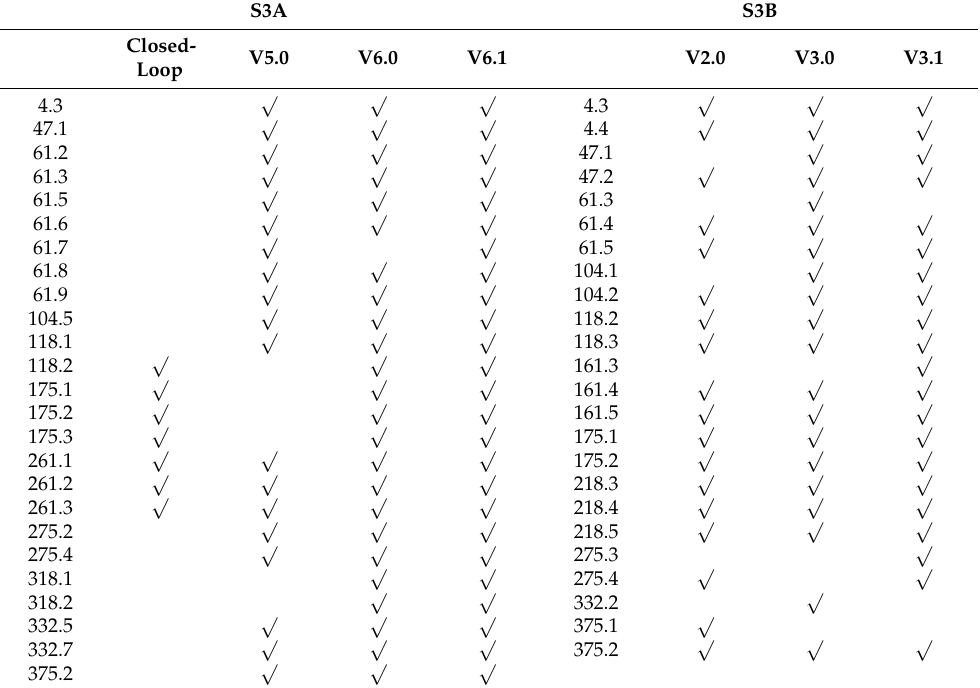
Table A4. Detection rate of each component, including stable, unstable, HW, HN, LW, LN, and different versions of